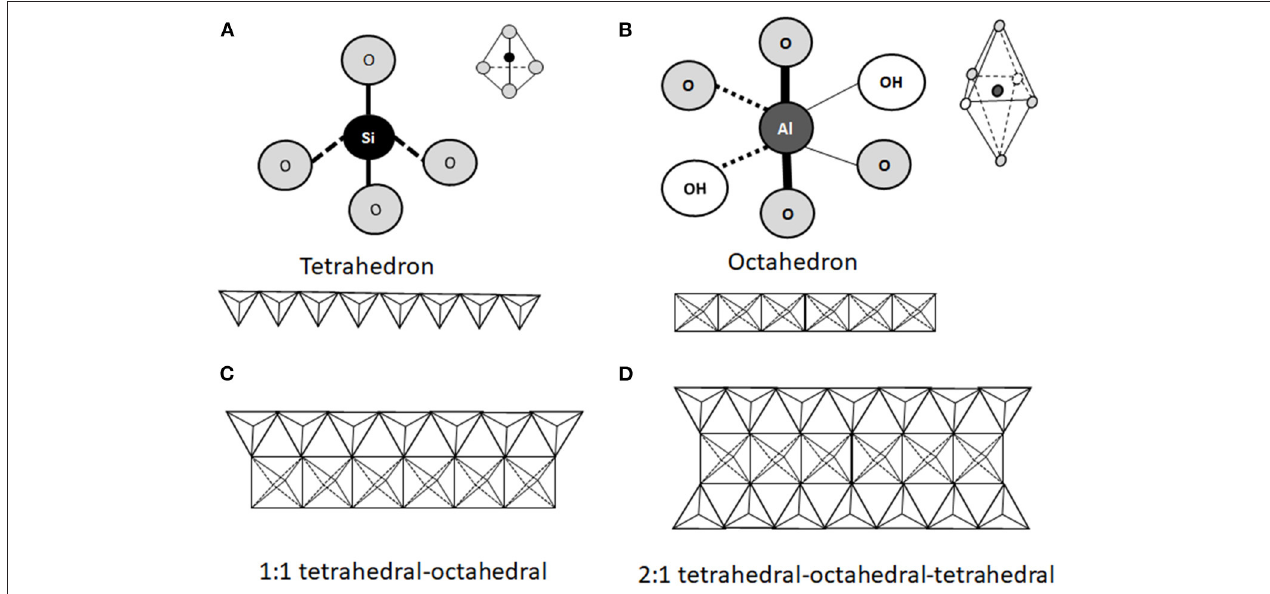
FIGURE 1 | Schematic representation of the structural units of phyllosilicates. The structure consists of a combination of tetrahedral silica (A) and octahedral aluminum (B) oxide layers exposing hydroxyl groups. Two types of phyllosilicates can be distinguished. The 1:1 tetrahedral-octahedral (T-O) type consists of one layer of tetrahedral SiO 4 joined to one octahedral aluminum (or manganese) layer (C) . The 2:1 tetrahedral-octahedral-tetrahedral (T-O-T) type consists in one octahedral aluminum (or manganese) layer between two tetrahedral SiO 4 layers (D)